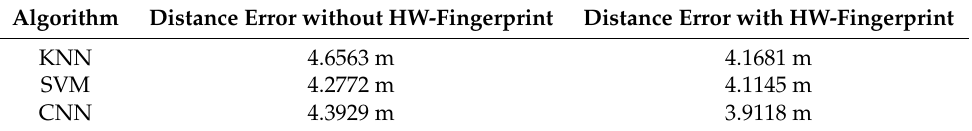
Table 7. Distance error.